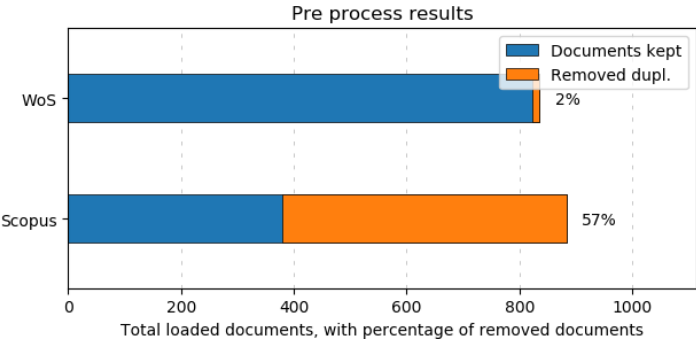
Figure 2. The pre-processing data from Scopus and WoS databases.